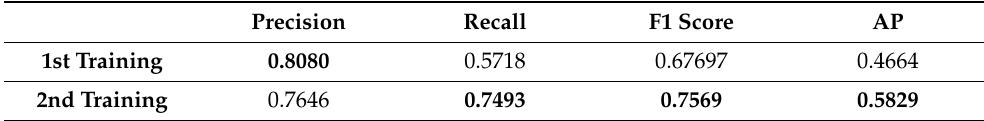
Table 3. Evaluating the accuracy of the DL